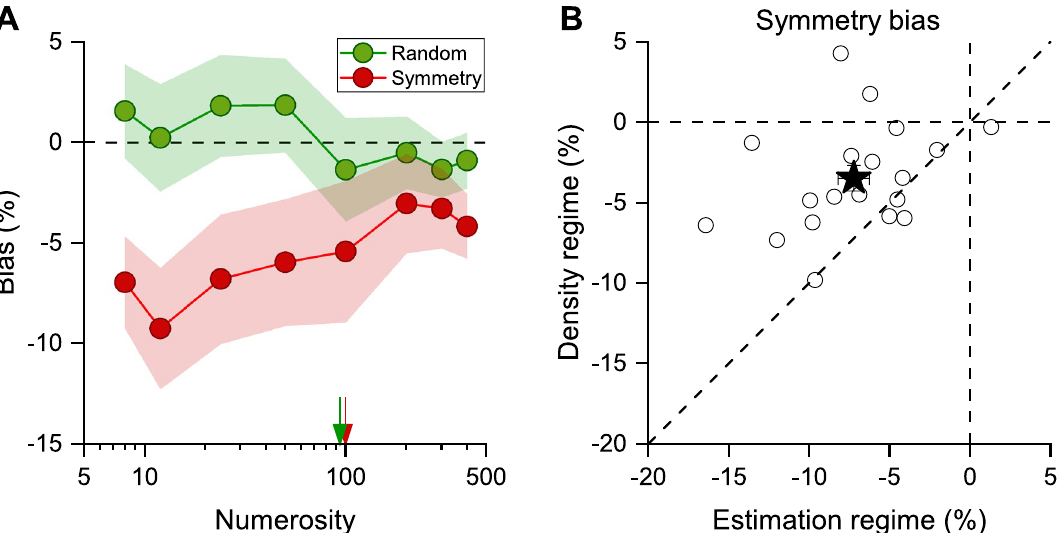
Figure 3. Numerosity bias for random and vertical symmetry stimuli. ( A ) Average bias across numerosities for the random (green circles) and symmetric (red squares) stimuli. Arrows indicate the switching point from the estimation to the density regimes for random (green) and symmetry (red) conditions. The shaded area represents 95% confidence interval. ( B ) Symmetry bias for individual participants (circles) for numerosities in the density regime (N200-N400) plotted as a function of symmetry bias in the estimation regime (N8-N50). The black star represents the average symmetry bias effect with error bars ± 1 s.e.m (about the size of the